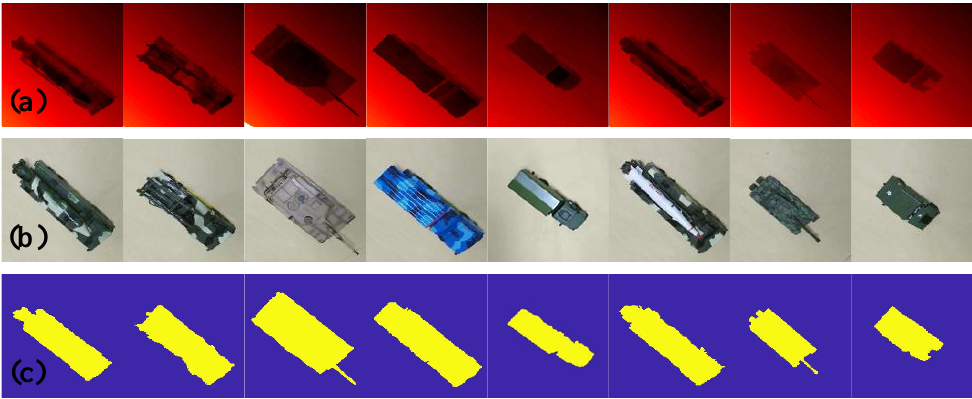
Figure 4. Acquired and pre-processed target object images. ( a ) Range images. ( b ) Intensity images. ( c ) Binary images.